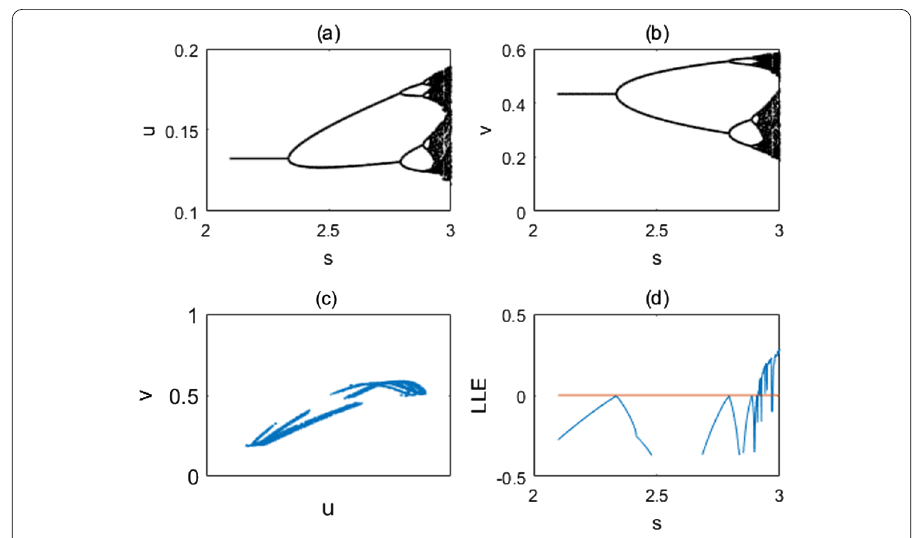
Figure 5 ( a ) Bifurcation diagram of map (1.4) in the ( s , u ) plane. ( b ) Bifurcation diagram of map (1.4) in the ( s , v ) plane. ( c ) Chaotic attractor for s = 3. ( d ) The largest Lyapunov exponents corresponding to a /